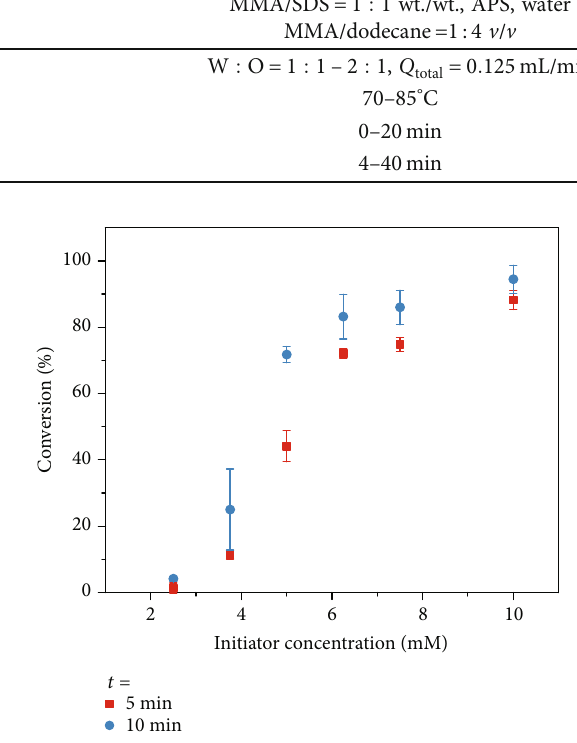
Figure 2: Temperature thresholds with di ff erent initiation systems in the capillary microreactor ( t = 10 min and the concentration of the initiator involved was 5mM).